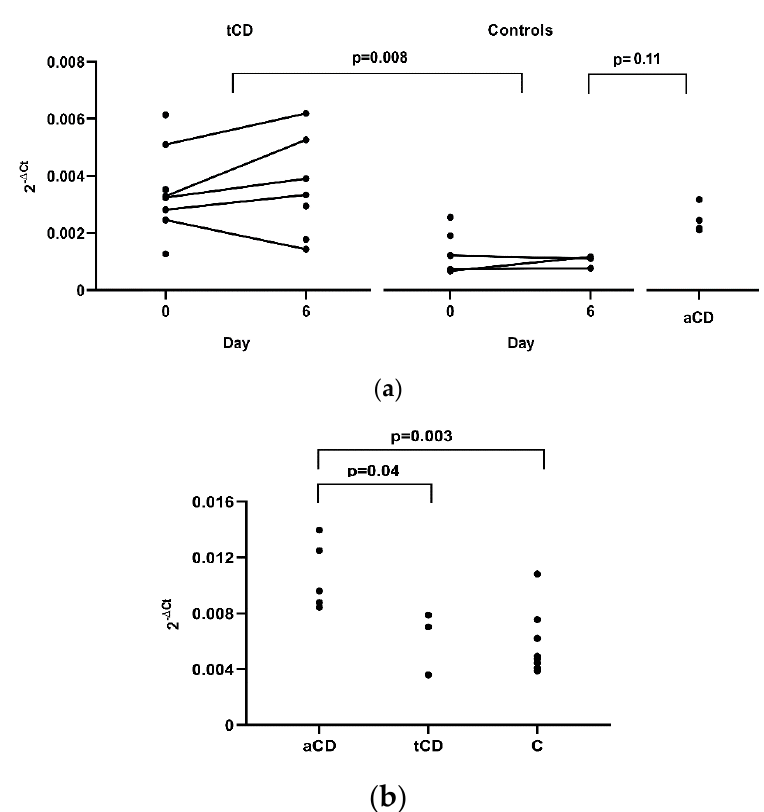
Figure 2. Gene expression patterns of CX3CL1 . Data correspond to 2 - Δ Ct , i.e., the relative expression of CX3CL1 mRNA compared with the endogenous gene in ( a ) peripheral blood of patients with coeliac disease (tCD) and healthy controls, following a gluten free diet and enrolled in a 3-day gluten challenge; and CD patients following a gluten containing diet (aCD); ( b ) duodenal tissue of patients with active (aCD) or treated (tCD) CD, and disease controls (C).